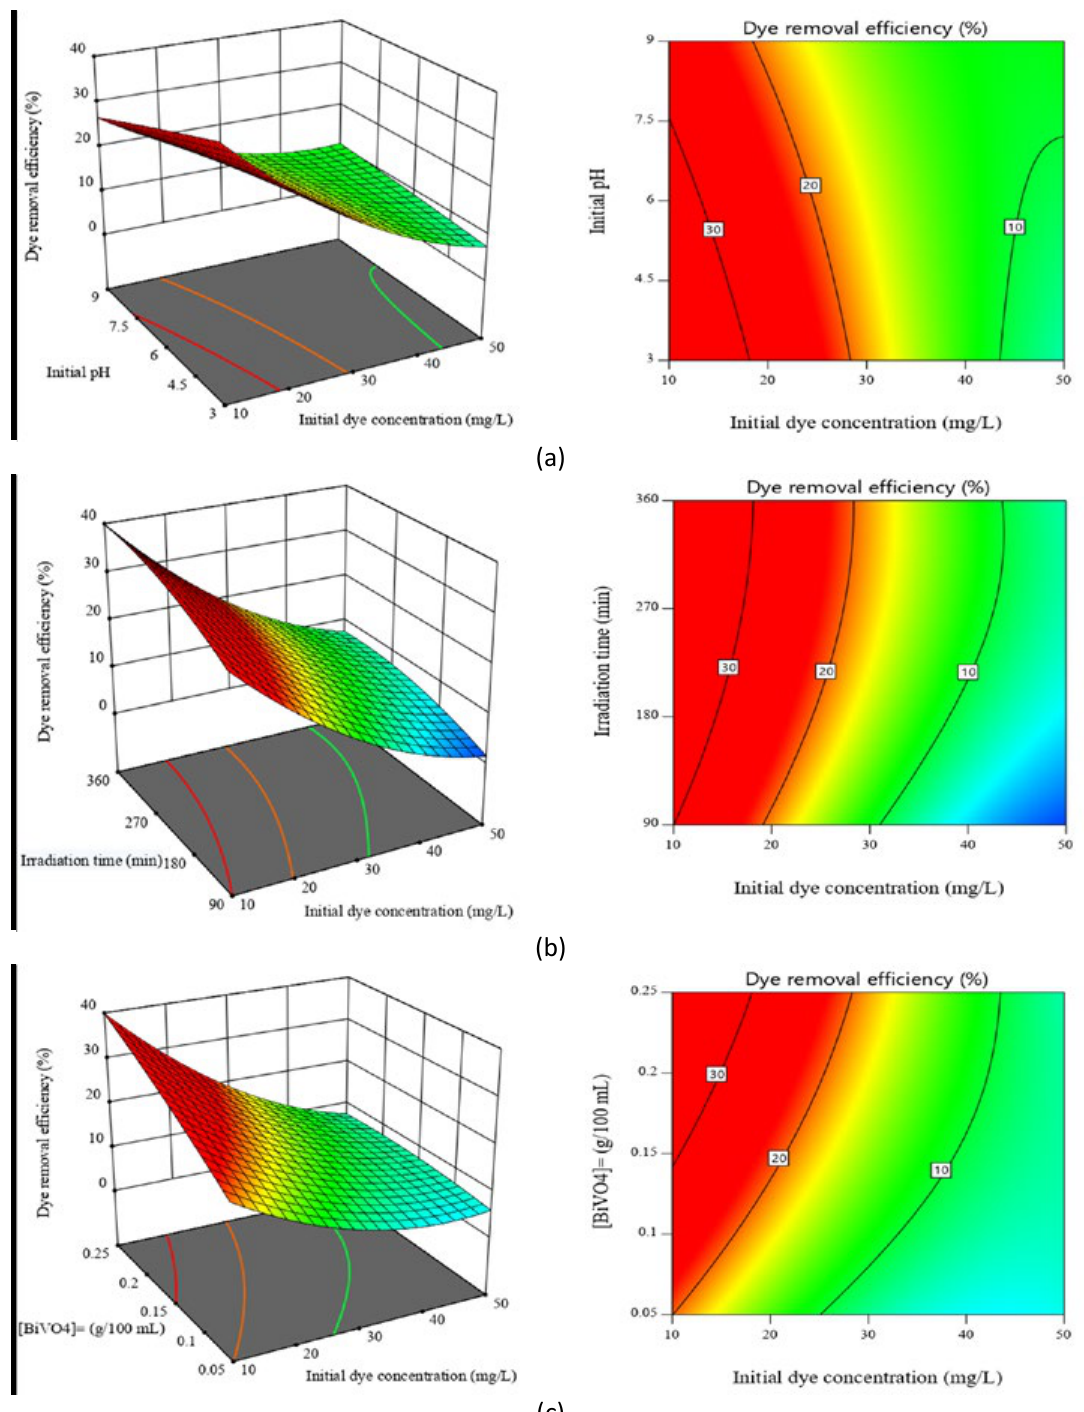
Fig. 12: The 3‐D response surface and 2‐D contour plot of the dye removal efficiency (%) as a function of initial dye concentration (mg/L) in terms of a) initial pH; b) irradiation time (min), and c) BiVO 4 dosage (g/100 mL)